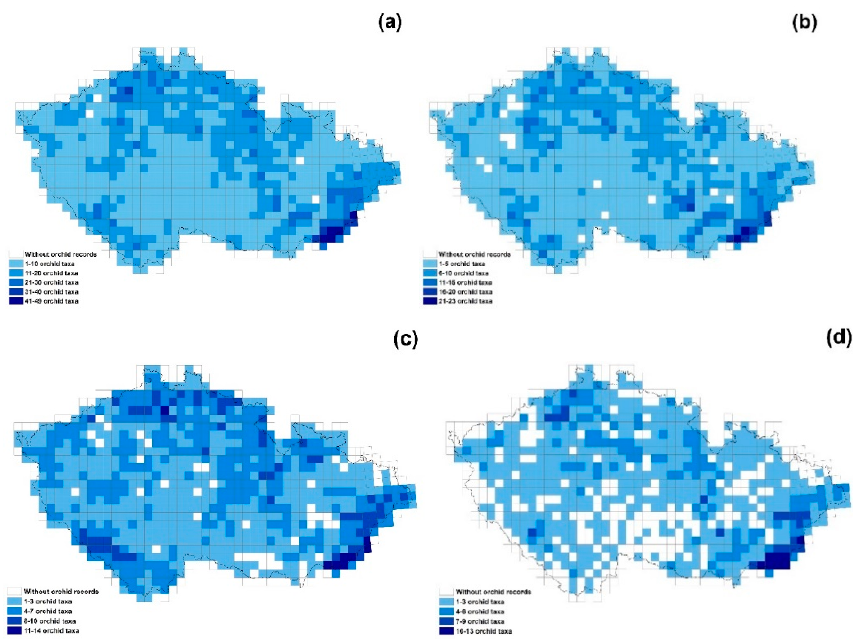
Figure 2. Maps of the Czech Republic showing the distributions of: ( a ) total number of orchid taxa, ( b ) rhizomatous, ( c ) intermediate and ( d ) tuberous orchid taxa.